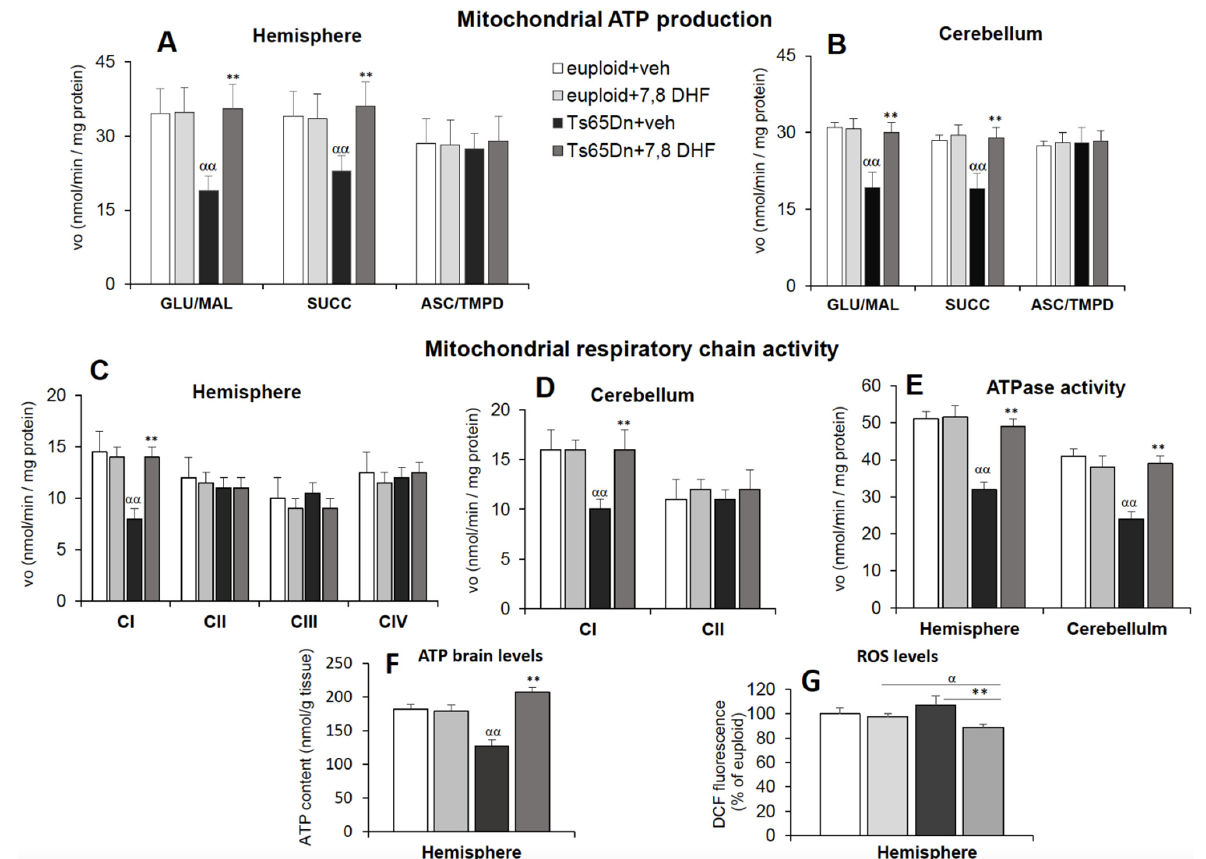
Figure 3. Neonatal treatment with 7,8-DHF improves the bioenergetic status in Ts65Dn mice. ( A , B ) Rate of ATP production was measured spectrophotometrically, as described in Figure 1, in isolated mitochondria from cryopreserved brain hem- ispheres ( A ) and cerebella ( B ) in the presence of the MRC respiratory substrates: glutamate plus malate (GLU/MAL), succinate (SUCC) or ascorbate plus TMPD (ASC/TMPD). Values are the mean ± SD of two independent measurements in 4 mice for each experimental group: vehicle-injected Ts65Dn mice (Ts65Dn + veh), 7,8-DHF-injected Ts65Dn mice (Ts65Dn + 7,8-DHF), vehicle-injected euploid mice (euploid + veh) and 7,8-DHF-injected euploid mice (euploid + 7,8-DHF). ( C – E ) Activity assays of complex I (CI), complex II (CII), complex III (CIII), complex IV (CIV) ( C , D ) and complex V (ATPase, CV) ( E ) were performed in mitochondrial membrane-enriched fractions from cryopreserved brain hemispheres and cere- bella of vehicle-injected Ts65Dn mice (Ts65Dn + veh), 7,8-DHF-injected Ts65Dn mice (Ts65Dn + veh), vehicle-injected eu- ploid mice (euploid + veh) and 7,8-DHF-injected euploid mice (euploid + 7,8-DHF). Rate values are the mean ± SD of two independent measurements in 4 mice for each experimental group, expressed as nmoles/min/mg protein. ( F ) Measure- ments of ATP brain levels were performed spectrofluorimetrically, as described in the Materials and Methods, in neutral- ized perchloric acid extracts of cryopreserved brain hemispheres of vehicle-injected Ts65Dn mice (Ts65Dn + veh), 7,8- DHF-injected Ts65Dn mice (Ts65Dn + veh), vehicle-injected euploid mice (euploid + veh) and 7,8-DHF-injected euploid mice (euploid + 7,8-DHF). Data are the mean ± SD of two independent measurements in 5 mice for each experimental group and expressed as nmoles ATP/g brain tissue. Significant differences between groups were calculated with one-way ANOVA and Tukey’s test. αα p < 0.01 Ts65Dn + veh vs euploid + veh; ** p < 0.01: Ts65Dn + 7,8-DHF vs Ts65Dn + veh vehicle. ( G ) ROS levels were detected as described in the Materials and Methods in cerebral hemisphere homogenates of vehicle-injected Ts65Dn mice (Ts65Dn + veh), 7,8-DHF-injected Ts65Dn mice (Ts65Dn + veh), vehicle-injected euploid mice (euploid + veh) and 7,8-DHF-injected euploid mice. Data are reported as the mean ± SD of 4 mice for each experimental group. ** = p < 0.01 Ts65Dn + 7,8-DHF vs. Ts65Dn + veh; α = p < 0.05 Ts65Dn + 7,8-DHF vs. euploid + veh by ANOVA with